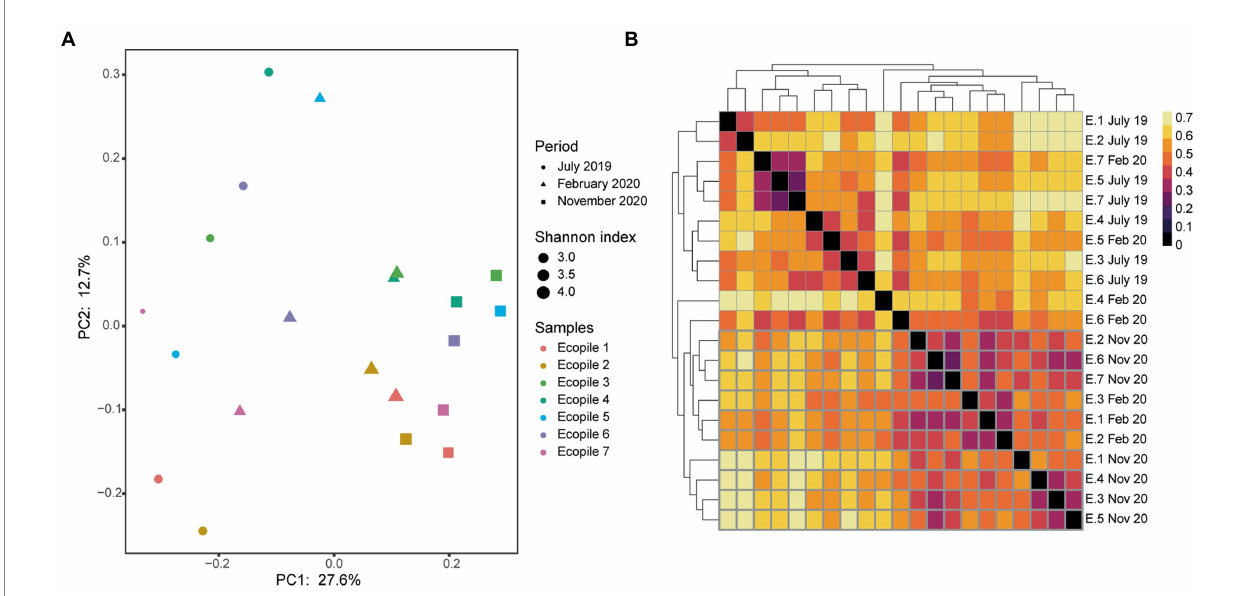
FIGURE 7 Clustering analysis of the fungal communities within Ecopiles along the different timepoints. (A) Principal coordinate analysis (PCoA) of Ecopiles using Bray-Curtis distances. Colors according to Ecopile, shapes according to timepoint and size according to Shannon index. Averages are represented for each ecopile and sampling time. (B) Heatmap of the hierarchical clustering of Ecopiles using Bray-Curtis distances and dendrogram. Color scale indicates Bray-Curtis